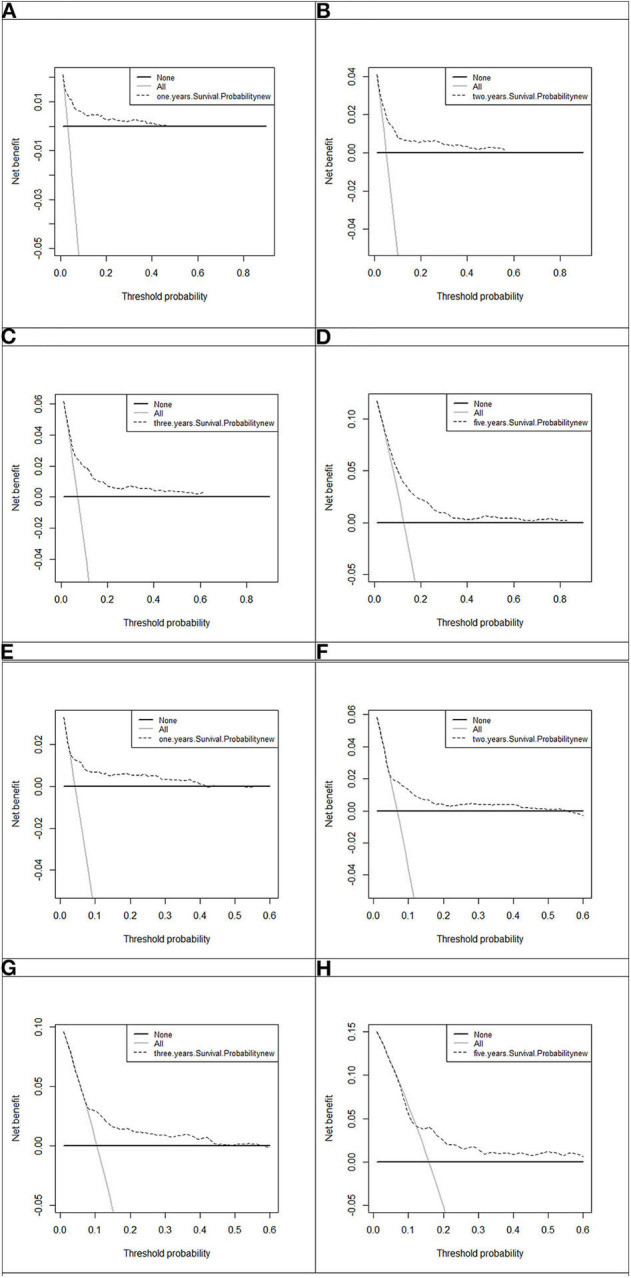
Decision curve analysis of 1, 2, 3, and 5 years in the derivation and 1, 2, 3, and 5 years in the validation cohort. The black line, assume no patients without disease (represented by None, i.e., the horizontal line). Gray line, all the MACE patients (represented by All, i.e., the oblique line). Dotted line represents the new established model. (A) One-year decision curve analysis in the derivation cohort; (B) 2-years decision curve analysis in the derivation cohort; (C) 3-years decision curve analysis in the derivation cohort; (D) 5-years decision curve analysis in the derivation cohort; (E) 1-year decision curve analysis in the validation cohort; (F) 2-years decision curve analysis in the validation cohort; (G) 3-years decision curve analysis in the validation cohort; (H) 5-years decision curve analysis in the validation cohort.